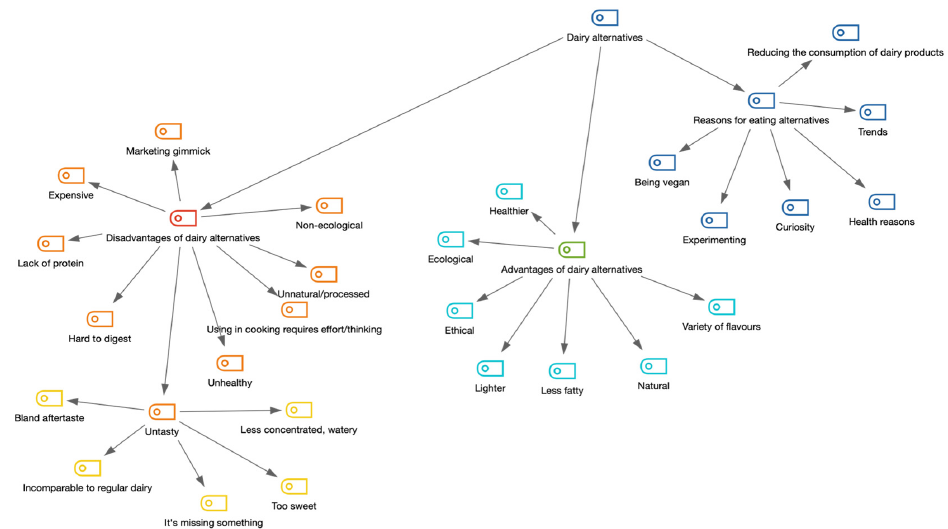
Figure 2. Visualization of codes connected to plant-based dairy alternative consumption (network of associations regardless of frequency).